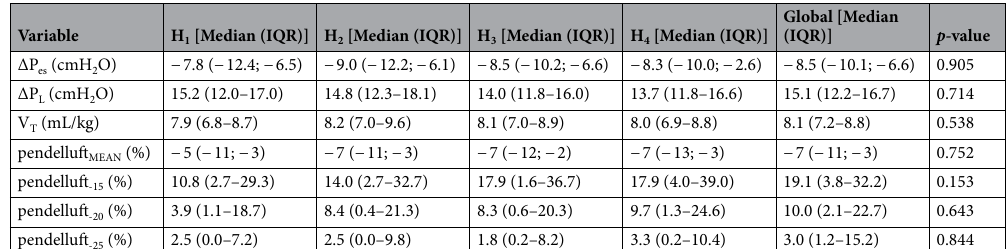
Table 1. Respiratory variables, mean pendelluft magnitude and pendelluft frequency at different magnitudes, during the study period. H 1 , H 2 , H 3 and H 4 represent the last 10-min of each monitoring hour within the 4-h study period; Global is the average between H 1 , H 2 , H 3 and H 4 ; pendelluft MEAN represents the mean of pendelluft magnitude and pendelluft -15 , pendelluft -20 , and pendelluft -25 , the pendelluft frequency at magnitudes − 15, − 20, and − 25%, respectively, measured in each time of monitoring; ΔP es : negative deflection of esophageal pressure (P es ) from the onset of inspiratory effort during the ventilatory cycle; ΔP L , tidal change in transpulmonary pressure, calculated as airway pressure (P aw) minus P es , between the maximum and minimum values of the ventilatory cycle: Both, ΔP es and ΔP L , were measured in cmH 2 O; V T (mL/kg PBW): tidal volume measured in mL/kg of predicted body